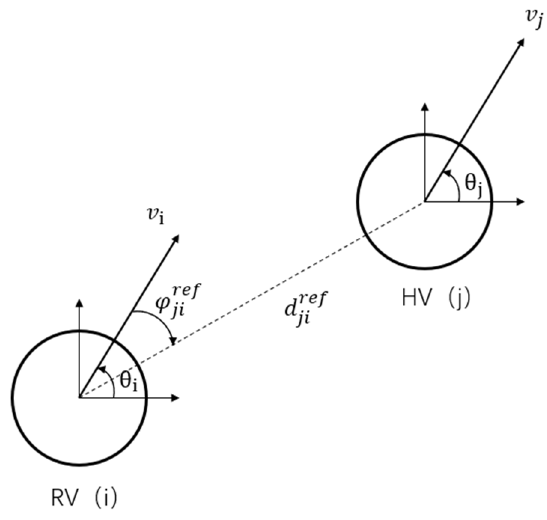
(cid:16) (cid:17) d ref , ϕ ref . ji ji (cid:0) − π (cid:1) , π are the expected relative distance and 2 2